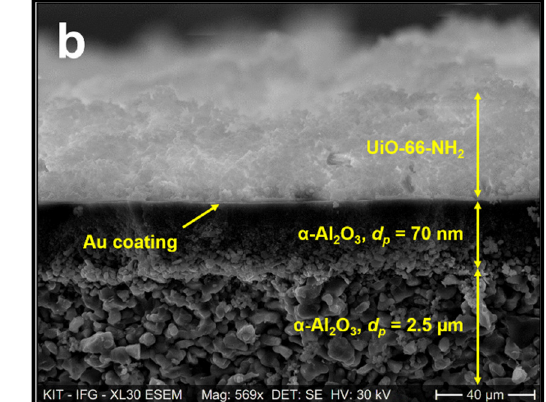
Figure 4. SEM images of ( a ) the top surface and ( b ) the cross-section of the U-LBL membrane.